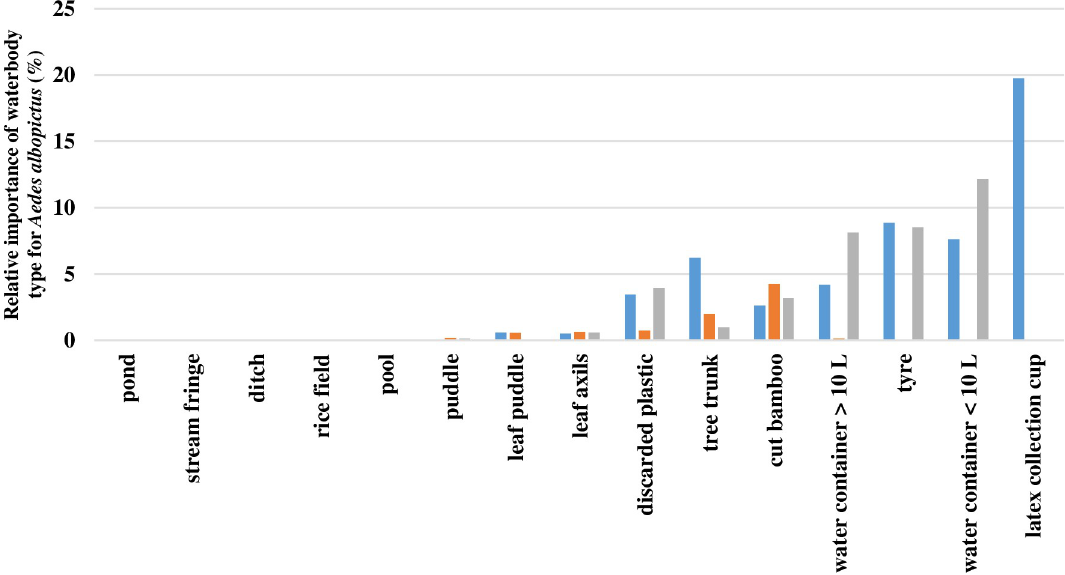
Fig 4. Relative importance of the waterbody types collected in villages (grey), mature rubber plantations (blue) and immature rubber plantations (orange) for the total number of emerged Aedes albopictus .